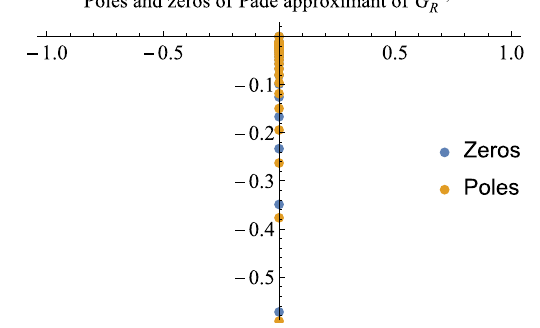
Fig. 15 Poles and zeros of 25th order Padé approximant of the shear channel correlation function. The cut of the (cid:17) -function is mimicked by a string of poles and